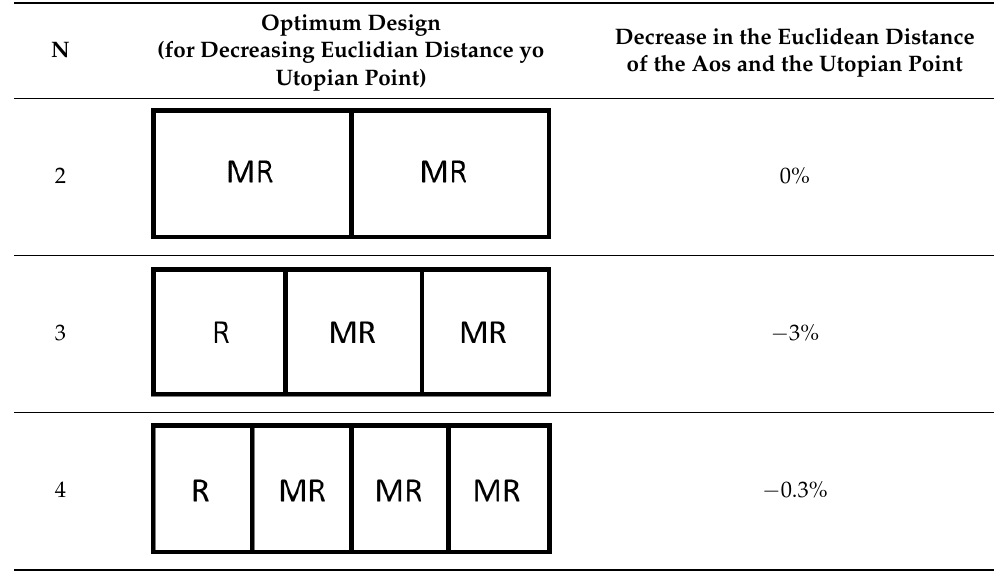
Table 4. Summary of the operability analyses for minimizing the Euclidean distance between the points in the AOS and the utopian point of 100% hydrogen recovery and carbon capture.